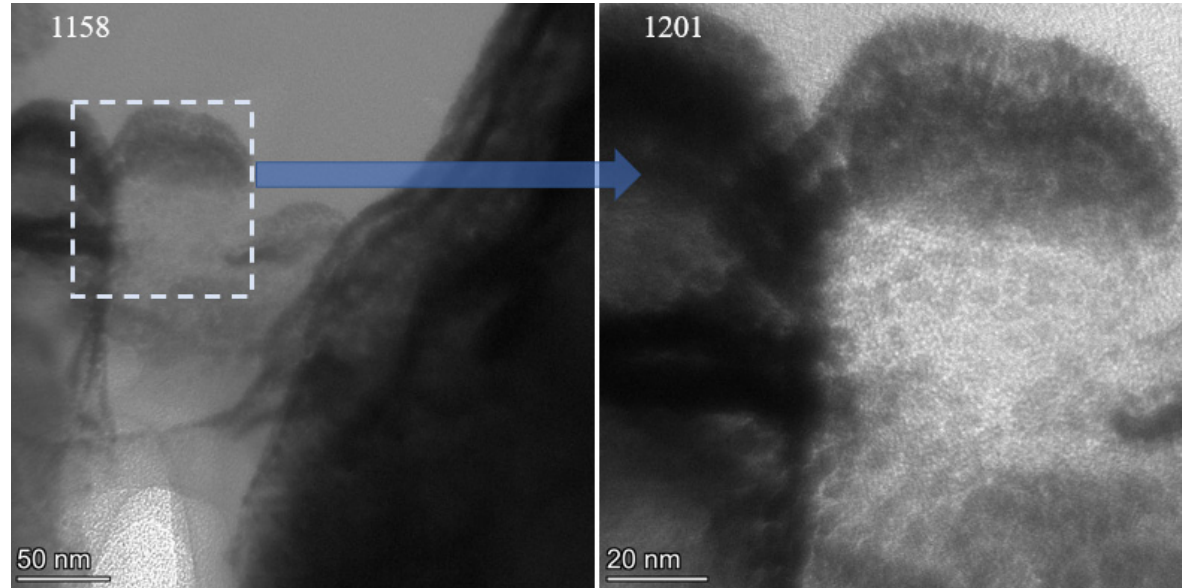
Figure 14. Area 1158 with inset shown for area 1201 (right). Area 1003